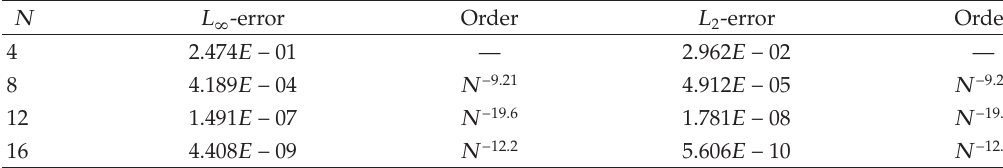
Table 2: Convergence rates at t (cid:7) 1 with μ (cid:7) 1, α (cid:7) 1, β (cid:7) 1, γ (cid:7) 3, n (cid:7) 2.